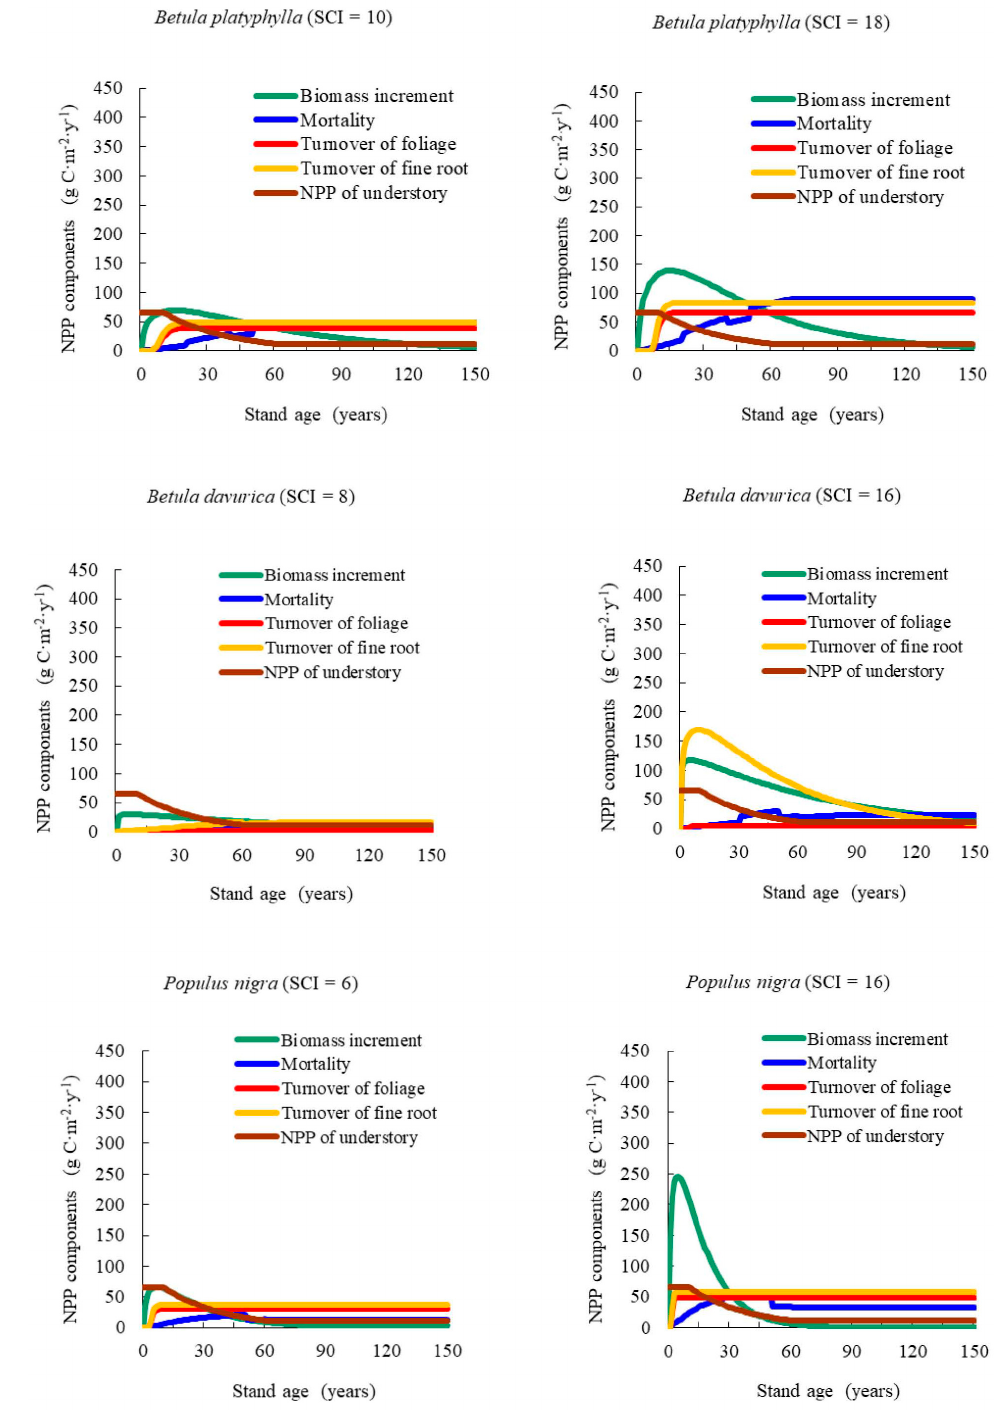
Figure A1. Variations of NPP components with age at minimum and maximum SCI for nine pure forest types.